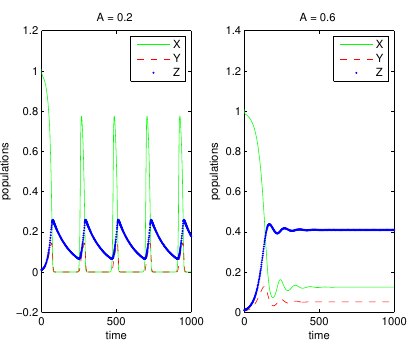
Figure 2. Parameter values: r = 0 . 6, c = 0 . 74, w = 0 . 38, s = 0 . 48, v = 0 . 05, d = 0 . 008, B = 0 . 85: left A = 0 . 2; right A = 0 .